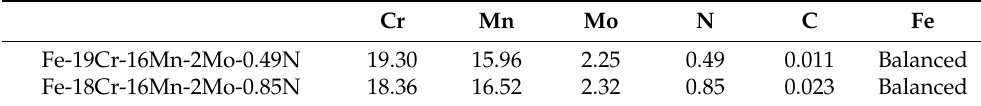
Table 1. Chemical compositions of the tested steels (wt.%). Cr Mn Mo N C